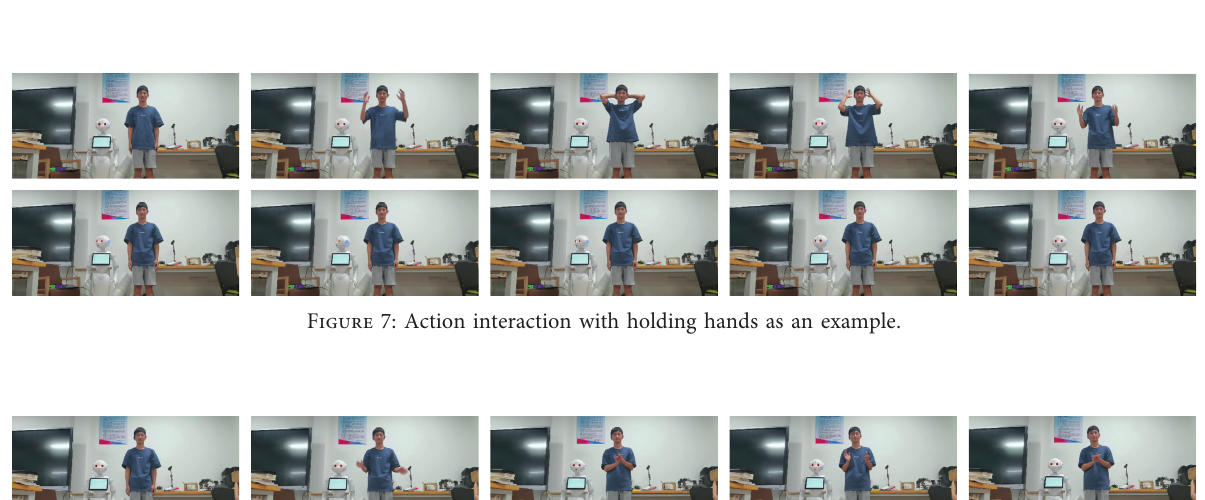
Figure 6: Action interaction with touching the ear as an example.